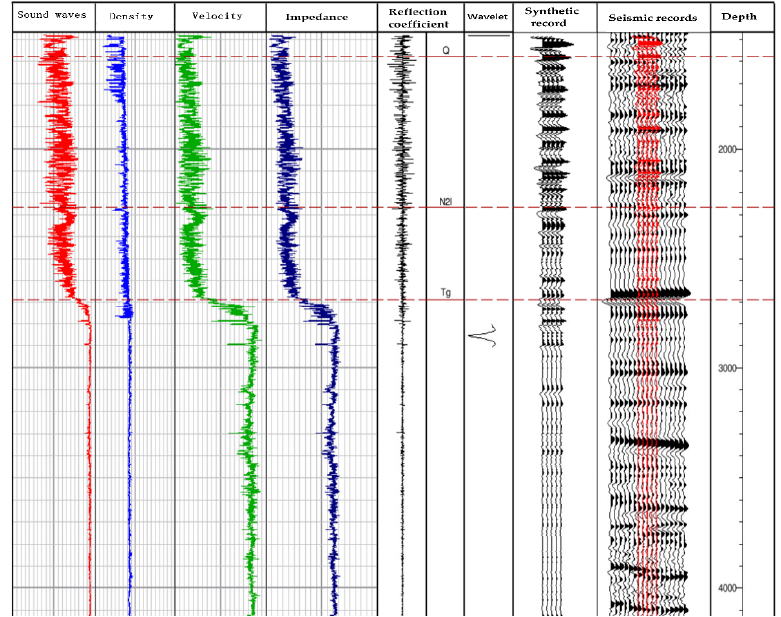
Figure 1. Composite logs of Well GH1 and the seismic section over it.